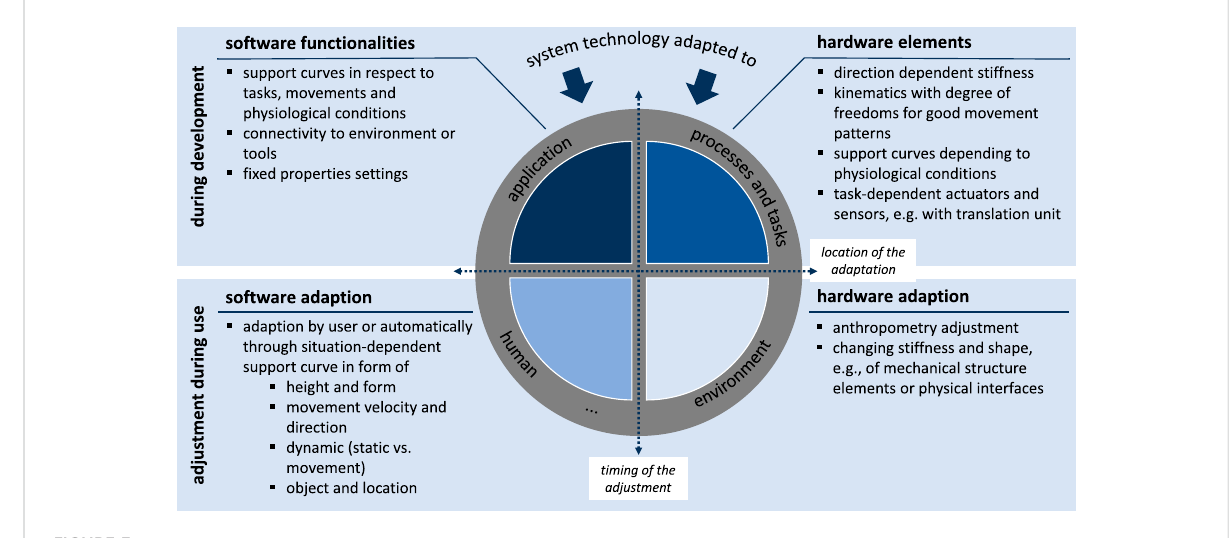
FIGURE 3 Possibilities of adaptation during the development phase and in application in hardware and software in